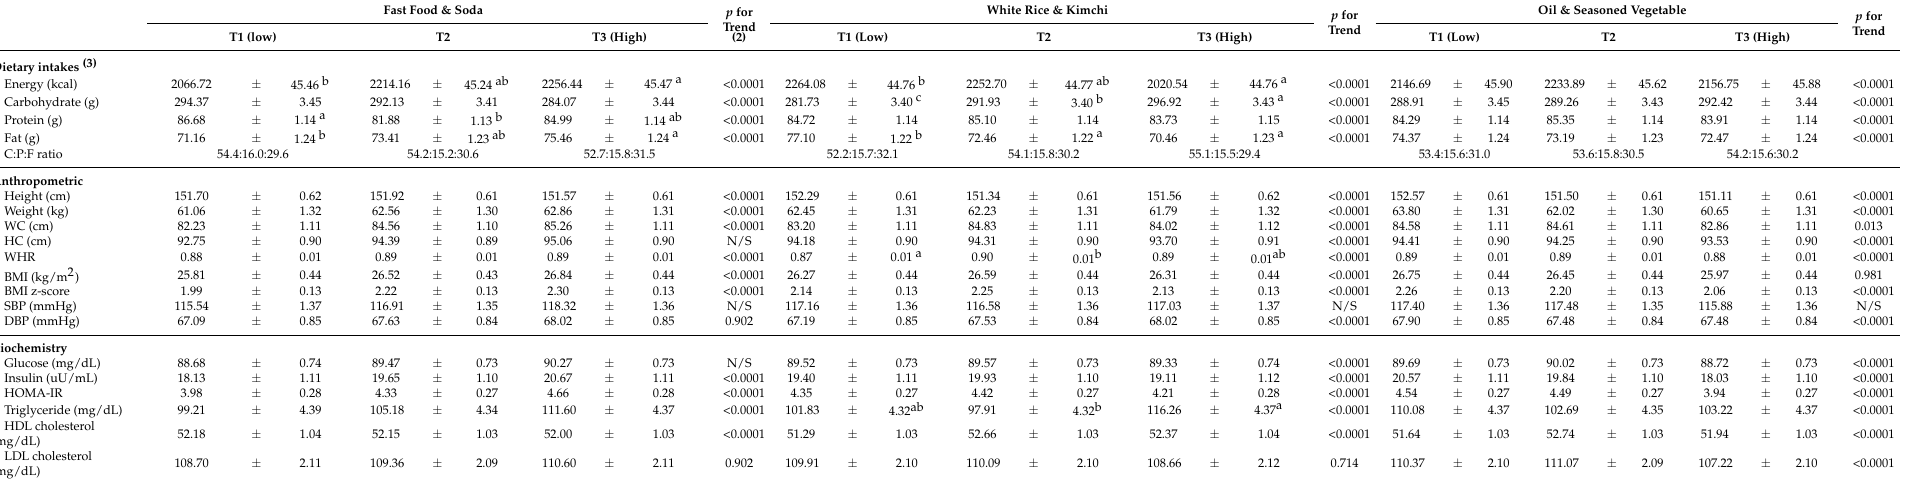
Table 3. Dietary intakes and metabolic risk factors according to tertile of dietary pattern for Korean children and adolescents (1),